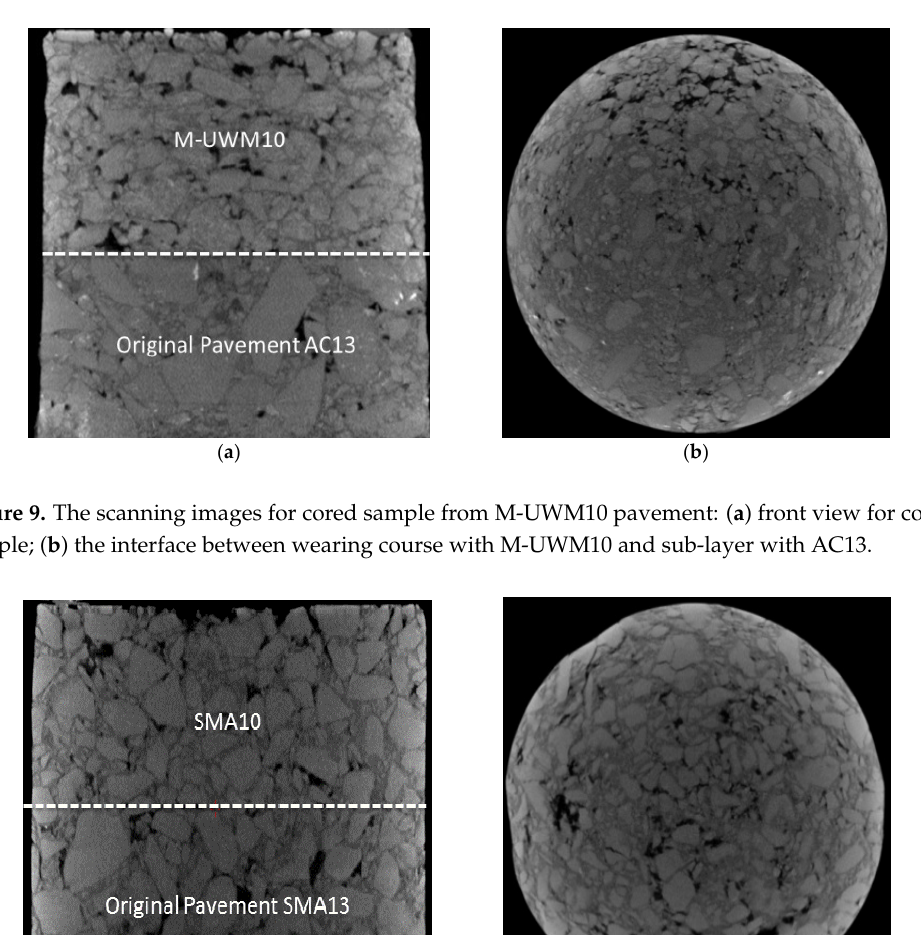
Figure 8. Examples of the cored samples from test roads and the restructuring graphs of wearing course mixtures: ( a ) cored samples; ( b ) restructuring graphs for M-UWM10 and SMA10.